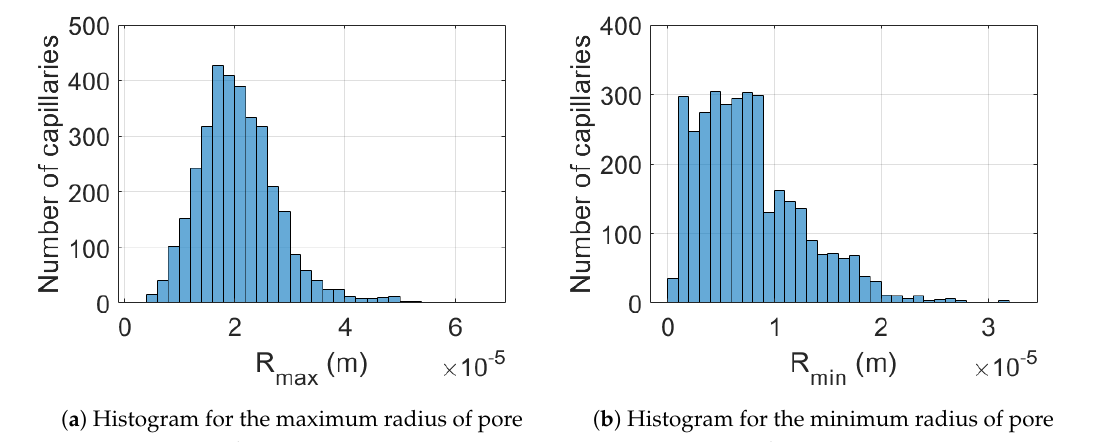
Figure 7. Histograms of pore throat dimensions of the adapted